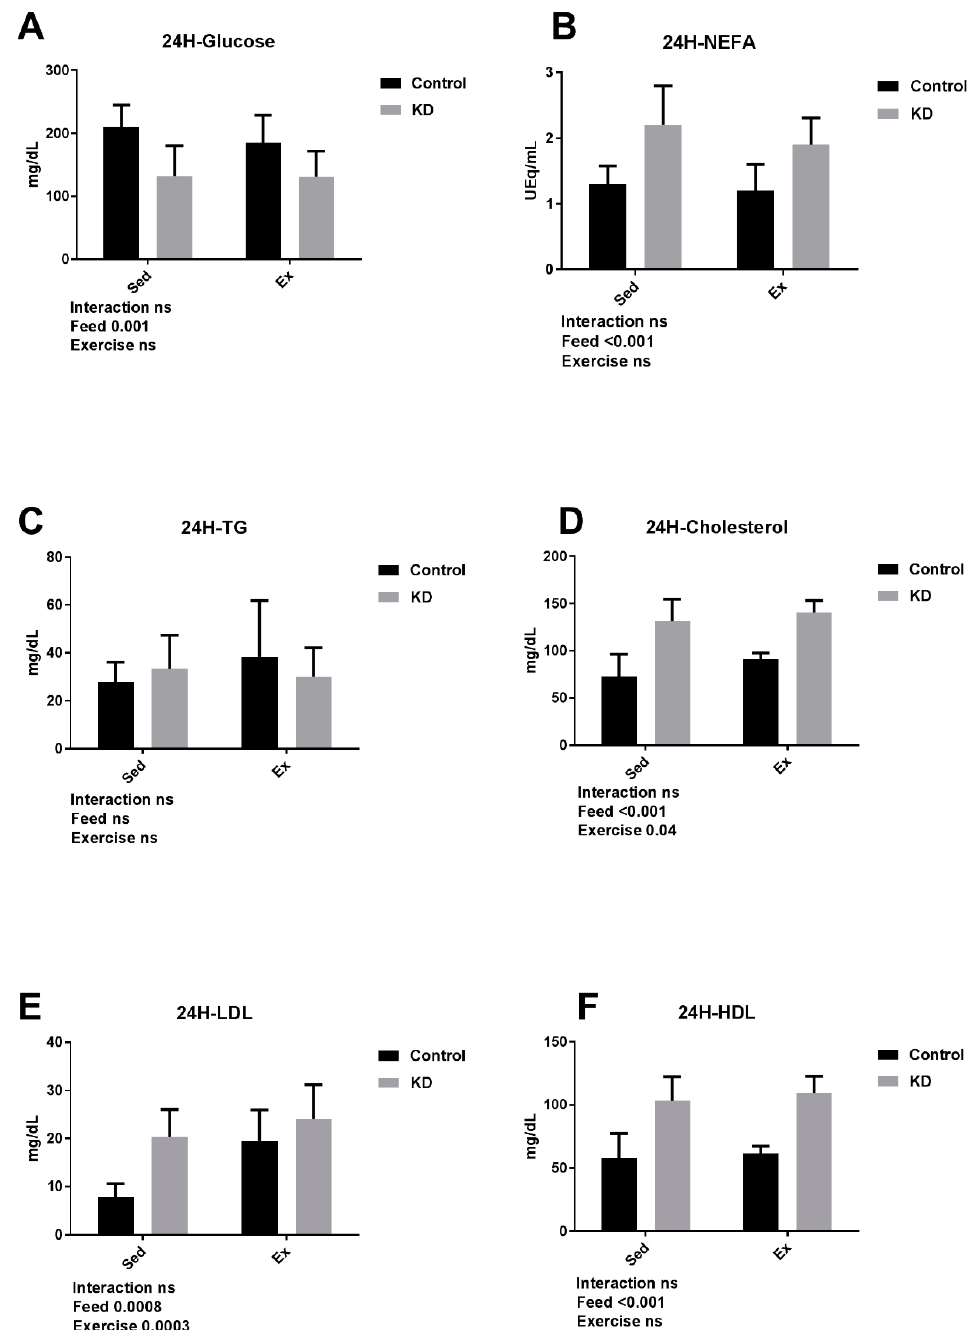
Figure 4. Plasma biochemistry results 24 h after exhaustion as indicated. ( A – F ) Concentrations of plasma glucose, non-esterified fatty acids (NEFA), triglyceride (TG), cholesterol (CHO), high-density lipoprotein cholesterol (HDL) and low-density lipoprotein cholesterol (LDL).